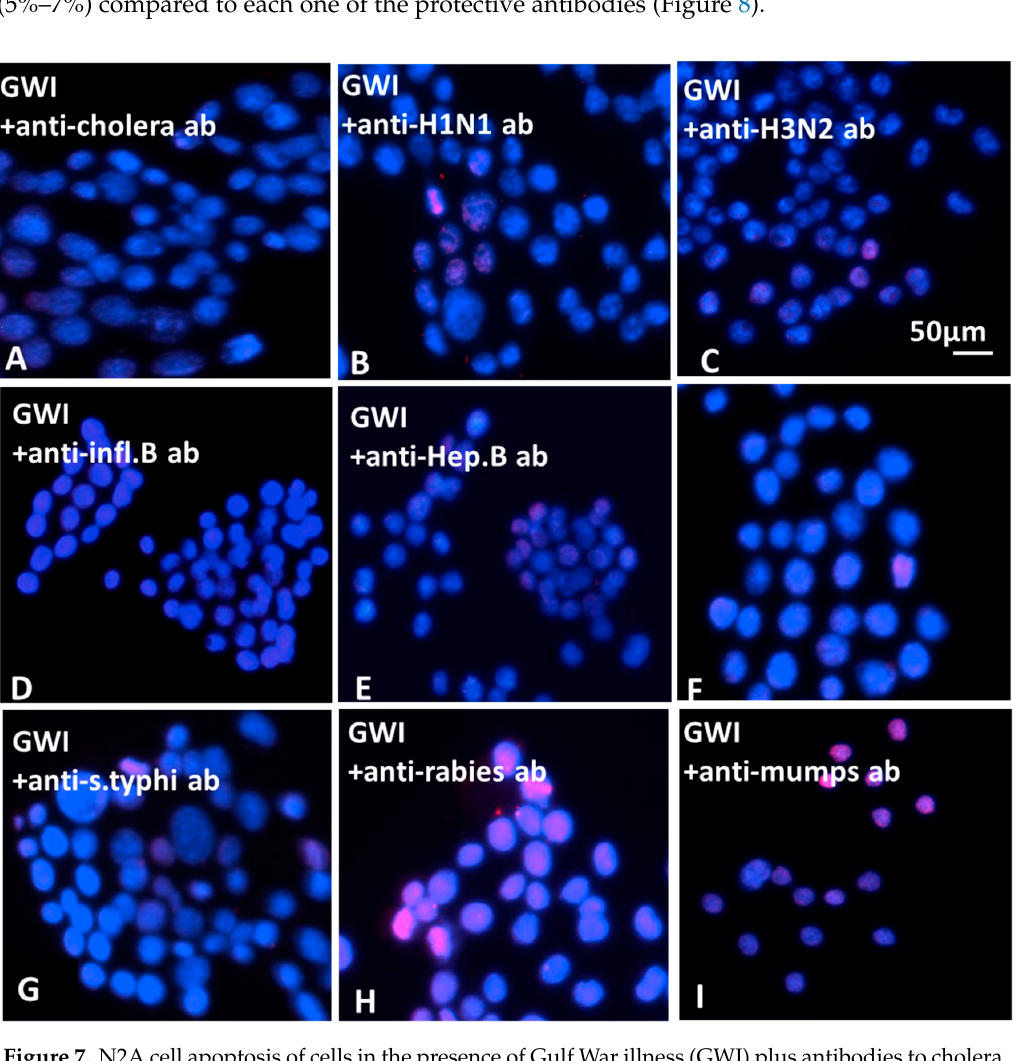
Figure 7. N2A cell apoptosis of cells in the presence of Gulf War illness (GWI) plus antibodies to cholera ( A ), influenza A / H1N1 ( B ), influenza A / H3N2 ( C ) influenza B ( D ), hepatitis B ( E ), measles ( F ), S. Typhi ( G ), rabies ( H ), and mumps ( I ). The antibodies were added in the culture medium simultaneously with GWI serum for two days. Most nuclei appeared healthy and stained with DAPI (blue); few nuclei were stained with TUNEL in Figure 7A–G (red). In Figure 7H,I, antibodies against rabies and mumps are shown to have no e ff ect, as most nuclei appear stained red with TUNEL.